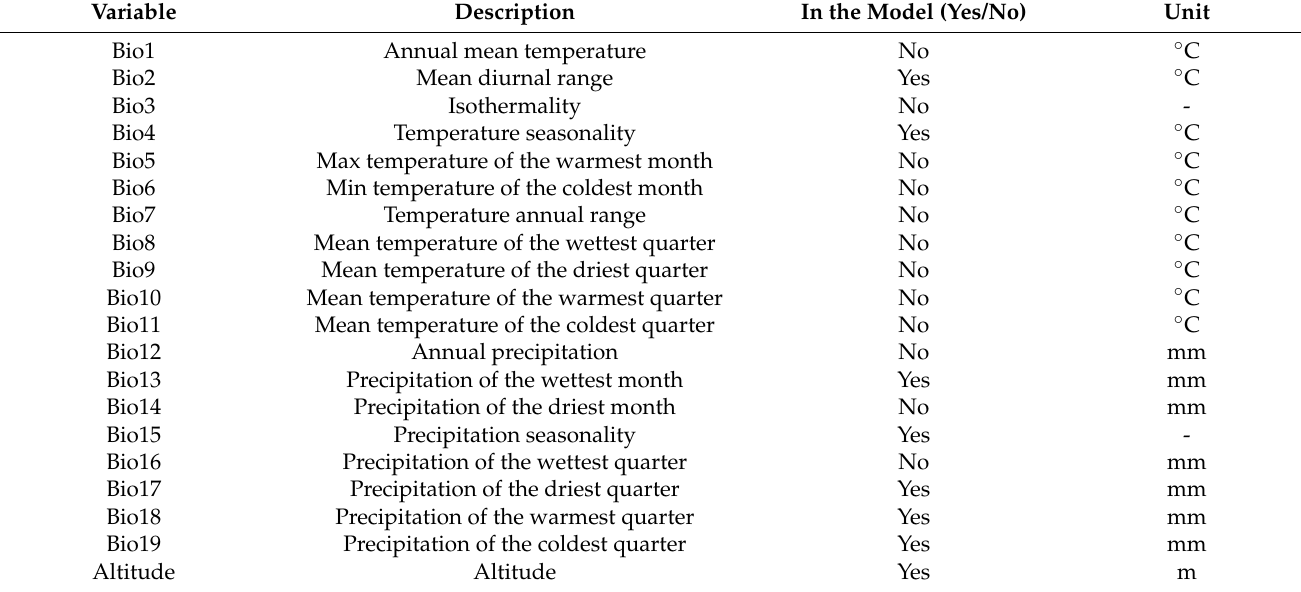
Table 1. Environmental variables related to the distribution of Helicoverpa zea .